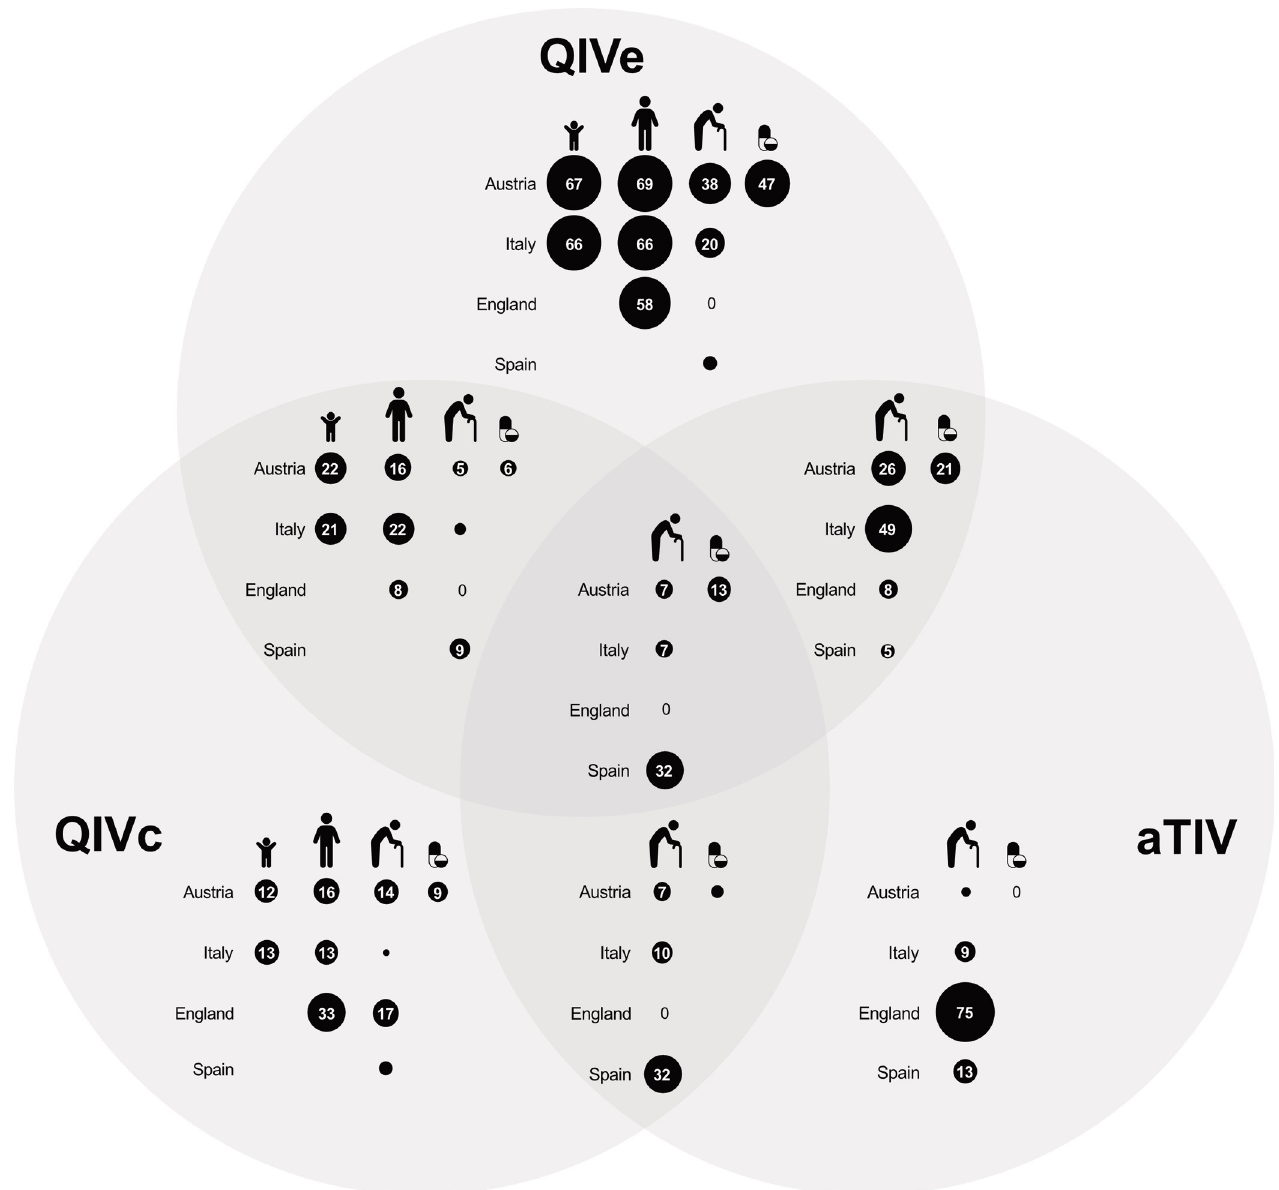
Fig 1. Vaccine type availability by risk group and country in 2019/20, as indicated by GPs (%). The risk groups are 1) children (healthy children 9-17y in Austria, children 10-17y with chronic conditions in Italy), 2) adults 18-64y (healthy adults in Austria, adults with chronic conditions in Italy and England), 3) adults � 65y, and 4) persons with chronic conditions or immunosuppression 18-64y in Austria. Empty circles represent values lower than